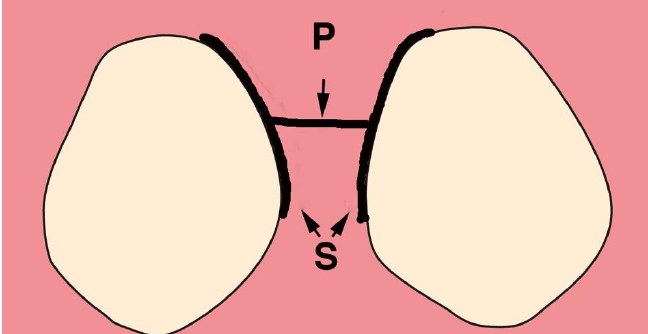
Figure 2. The incisions used for Videoscope-Assisted Minimally Invasive Surgery (VMIS). The incisions are made on the lingual aspect in the area of bone loss. Sulcular incisions (S) are made on the lingual aspect of the teeth adjacent to the area of interproximal bone loss. A split-thickness connecting incision is made at the base of the papilla (P).